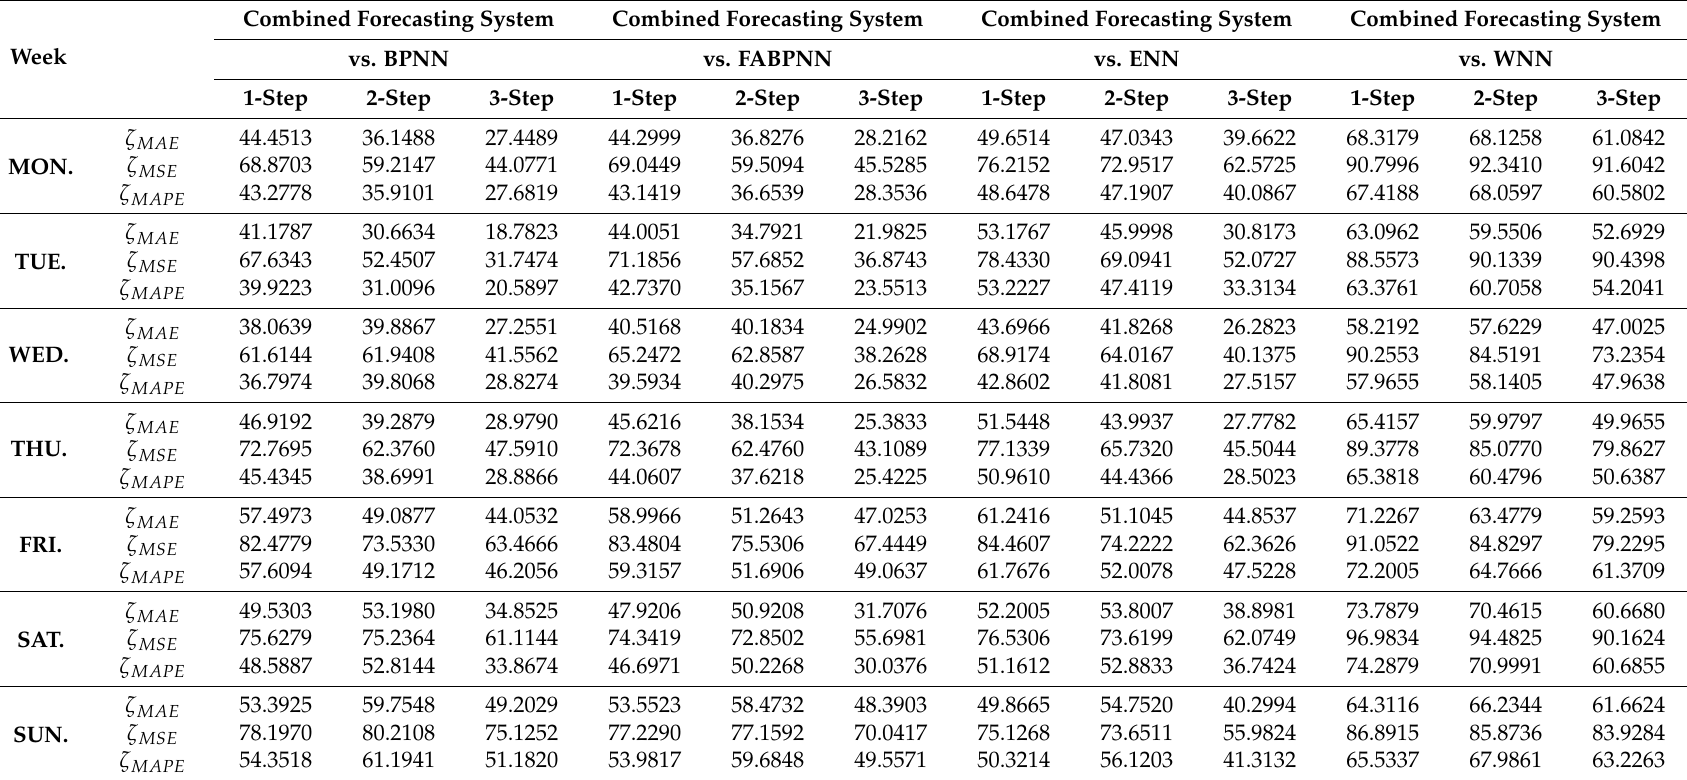
Table 5. Improvement percentages generated by the combined forecasting system from February